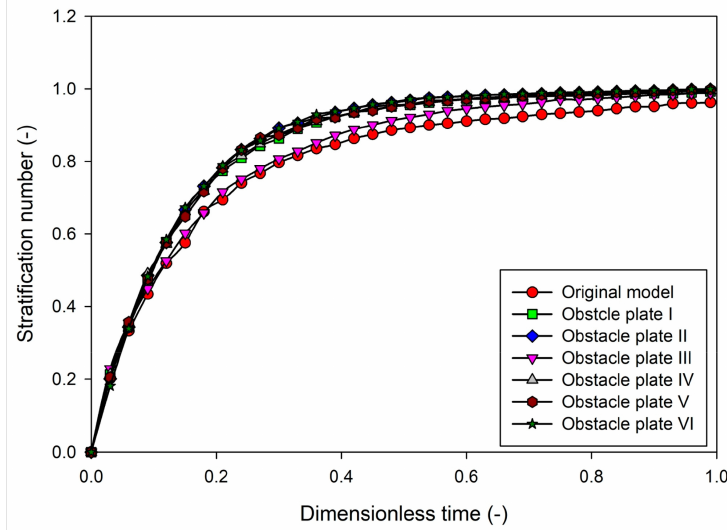
Figure 20. The stratification numbers of the obstacle plate